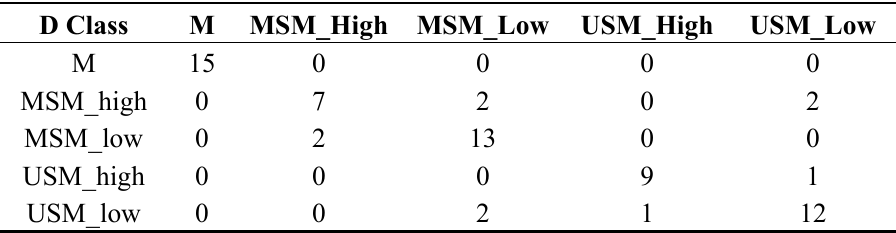
Table 3. K nearest neighbor (KNN) confusion matrix constructed by “leave-one-out” procedure over f-PCA of first derivative of cyclic voltammetries sections of La Serenisima adulterated and non-adulterated milk samples. Adulterated milk samples were grouped divided into high or low adulteration level. High level was composed by MSM or USM and USM , respectively. Low adulteration group was composed by MSM 1 2 and MSM or USM , USM , and USM , respectively. M : 5 3 4 5